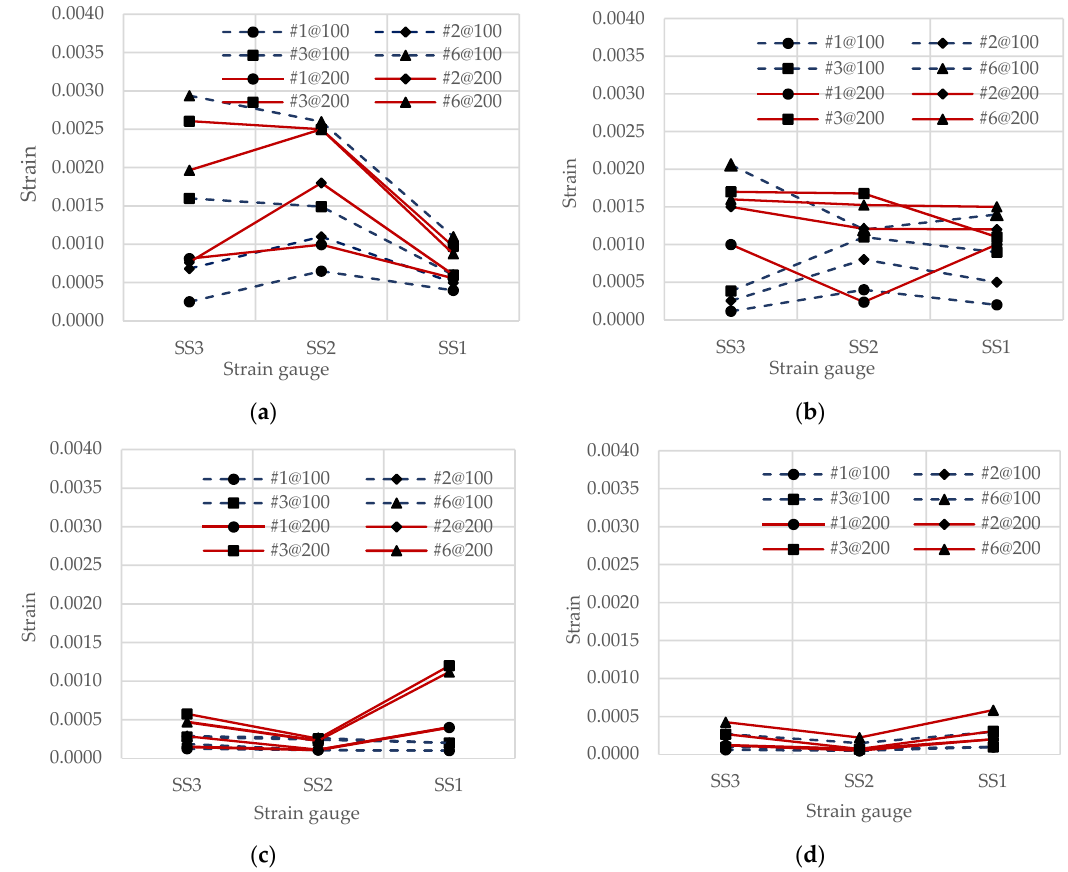
Figure 7. Strains of stirrups: ( a ) specimens I00-1 and I00-2, ( b ) specimens I14-1 and I14-2, ( c ) specimens I21-1 and I21-2, and ( d ) specimens I28-1 and I28-2.